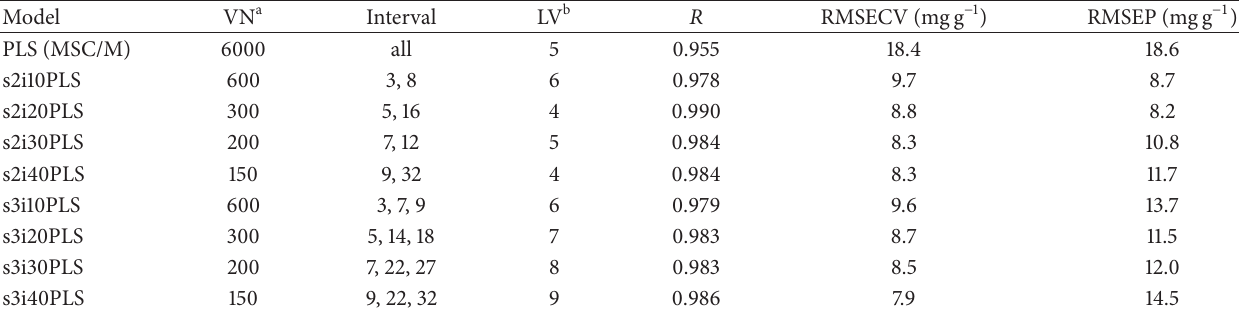
Table 2: Results obtained using siPLS algorithm for propranolol hydrochloride determination by FTNIR/PROBE.